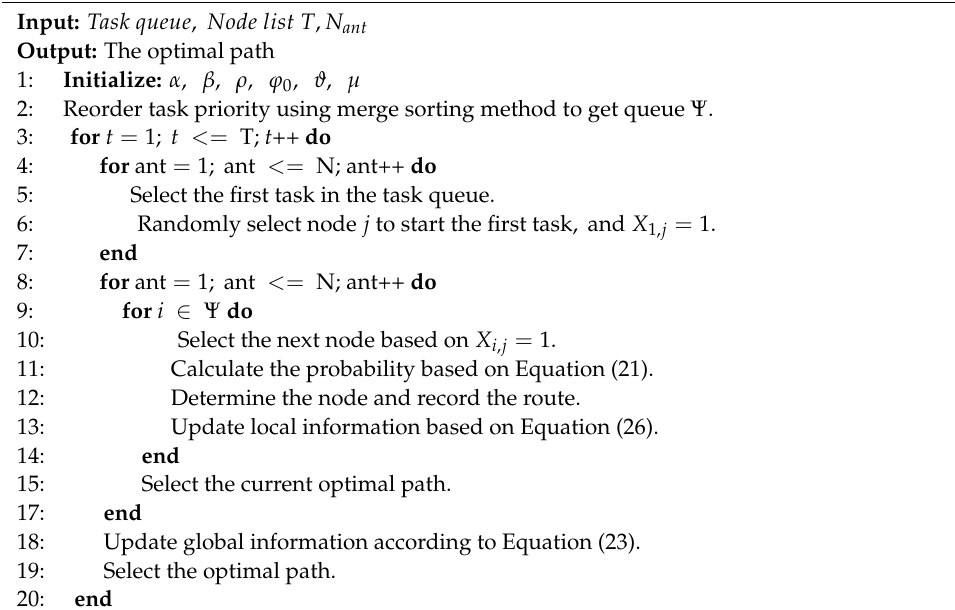
Algorithm 2: The Improved Ant Colony